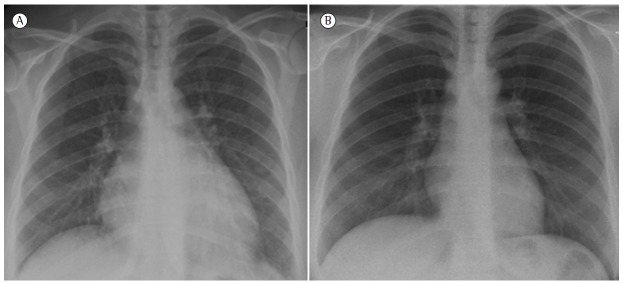
 Em A, radiografia de tórax na admissão hospitalar mostrando padrão
intersticial misto (reticular e micronodular) e cardiomegalia. Em B,
radiografia de tórax na alta hospitalar mostrando a normalização dos campos
pulmonares e da área cardíaca.